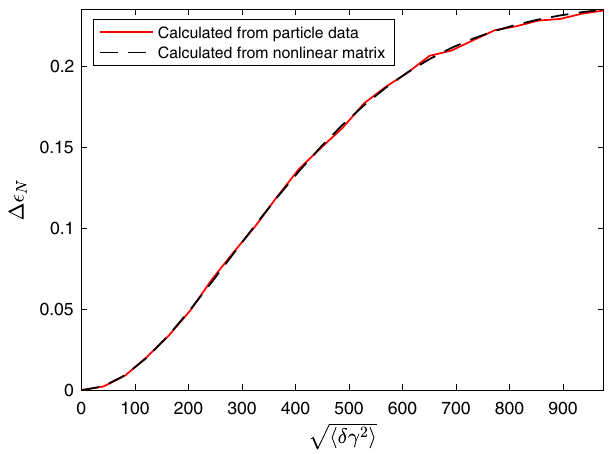
FIG. 3. Normalized emittance growth through a nonlinear matrix calculated by summing over a large number of particle tracks (blue) compared the calculation using Eq. (36) (red), as a ffiffiffiffiffiffiffiffiffiffi p function of h δγ 2 i